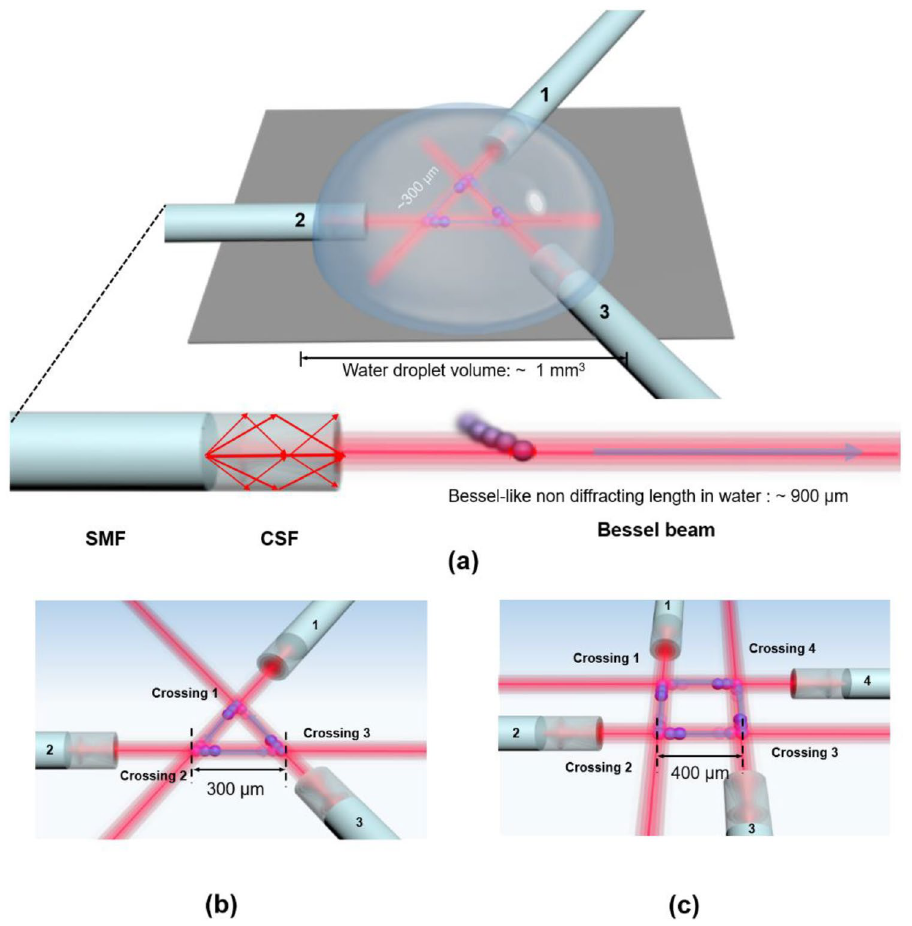
Figure 1. ( a ) A schematic diagram of the proposed optical polygonal circulations in a single water droplet. The lower diagram shows the multimode interference along the concatenated single mode fiber (SMF) and coreless silica fiber (CSF) to generate a Bessel-like beam, which traps and transports dielectric beads in a water droplet. ( b ) Triangular optical circulation enabled by crossing three nearly identical fiber optic Bessel-like beams in the water droplet. Here “Crossing” denotes the intersection of two Bessel-like beams. ( c ) Rectangular optical circulation enabled by crossing four nearly identical fiber optic Bessel-like beams in the water